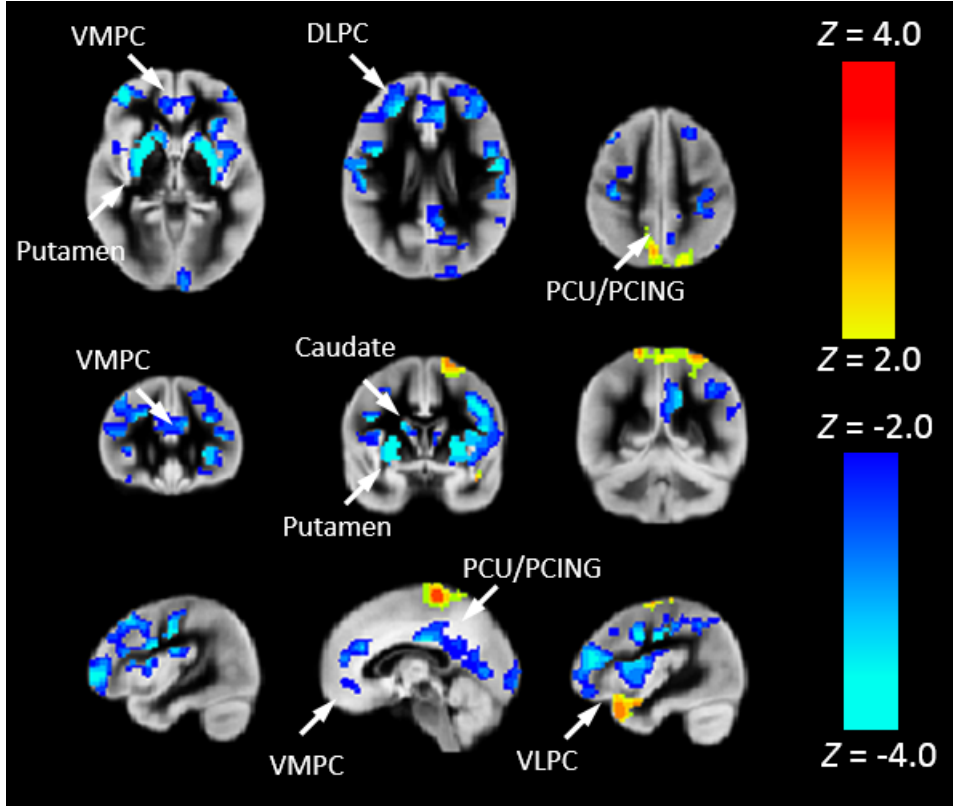
Figure 7. Nasal nitric oxide (nNO) mediates Pnvf in children and younger adults with CHD. Regions with a negative indirect effect (cold colors) or positive indirect effect (hot colors) with CHD status the independent variable, Pnvf the dependent variable, and nNO measurements the mediator (controlling for age and gender) are concentrated in similar regions as shown in Figure 6. All regions significant at FDR-corrected q < 0.05. Abbreviations: Ventrolateral medial prefrontal cortex (VMPC), Insula (INS), Dorsolateral prefrontal cortex (DLPC), Posterior Cingulate (PCING), Precuneus (PCU), Dorsal Anterior Cingulate Cortex (DACC), Posterior Parietal (PP).